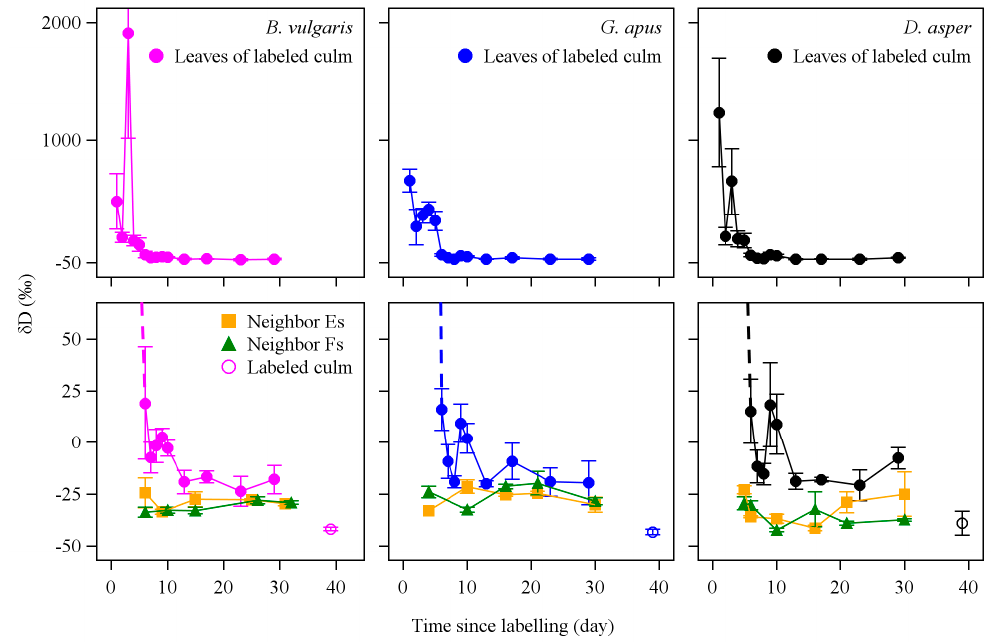
Figure 2. Deuterium signature ( δ D, ‰, mean ± standard error) in transpired water of labeled culms of B. vulgaris , G. apus , and D. asper over the course of the experiment (first row). Comparison among δ D values in transpired water of labeled culms and in culm water of neighbor-established (Neighbor Es) and freshly sprouted culms (Neighbor Fs), starting five days after labeling (second row). Day 0 is the day of deuterium injection. The background value (labeled culm) was derived by averaging culm δ D values of cut-down labeled bamboos after the experiment.